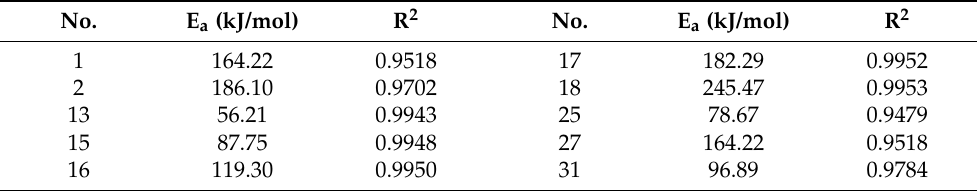
Table 8. Calculated results of TBPTMH at different G ( α ) by Coats–Redfern method.